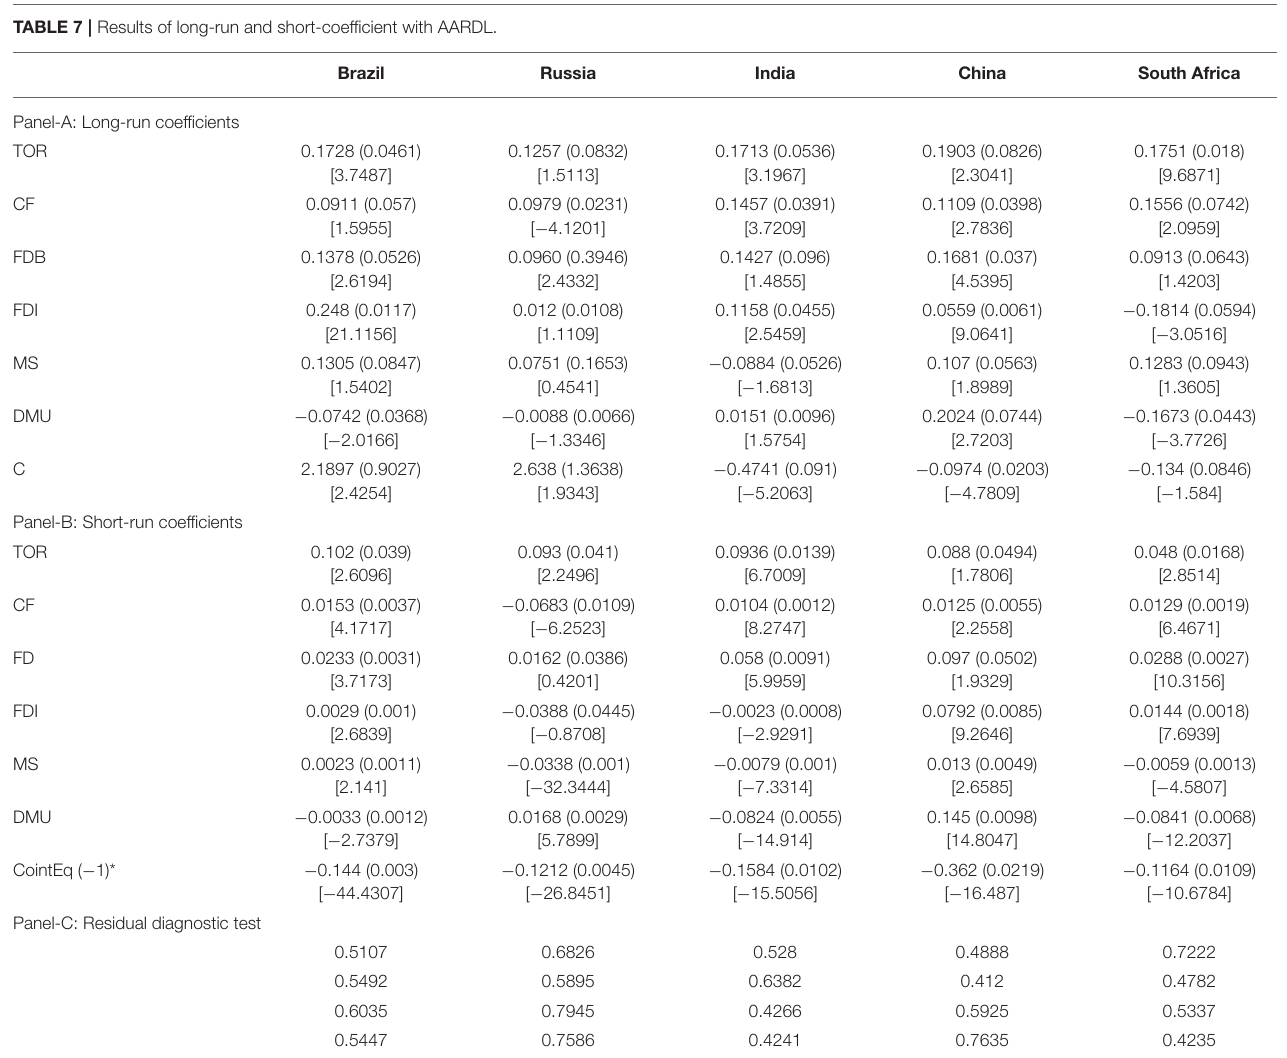
TABLE 7 | Results of long-run and short-coefficient with